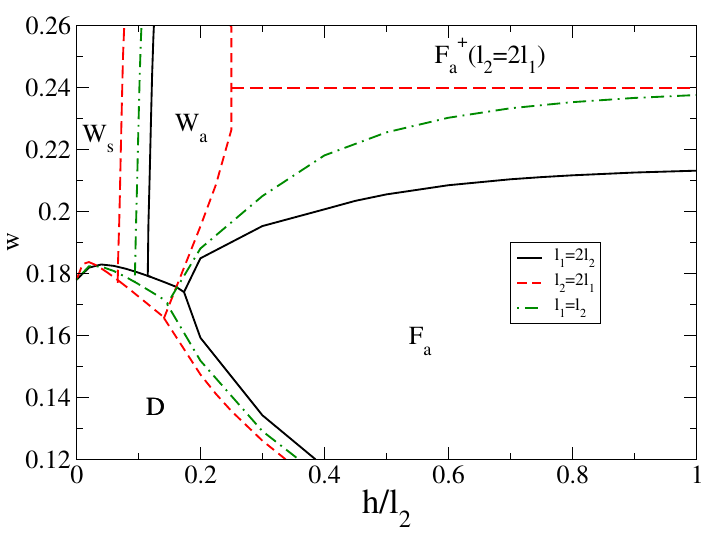
Figure 6. The same as Figure 4 for λ = 10 3 .